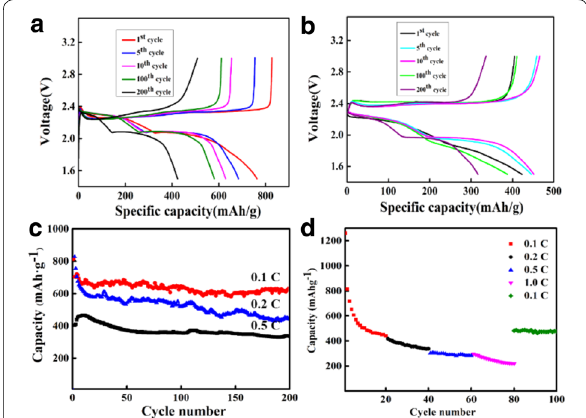
Figure 6 Electrochemical performance of TiO 2 /S nanocomposite structures. Galvanostatic charge-discharge voltage profiles of TiO 2 /S cathodes between 1.5 and 3.0 V at a 0.2 C, b 0.5 C, c Cycling performance of TiO 2 /S cathodes at a current density of 0.1 C, 0.2 C and 0.5 C, d Rate capability of TiO 2 /S composite electrodes at various current densities from 0.1, 0.2, 0.5 to 1